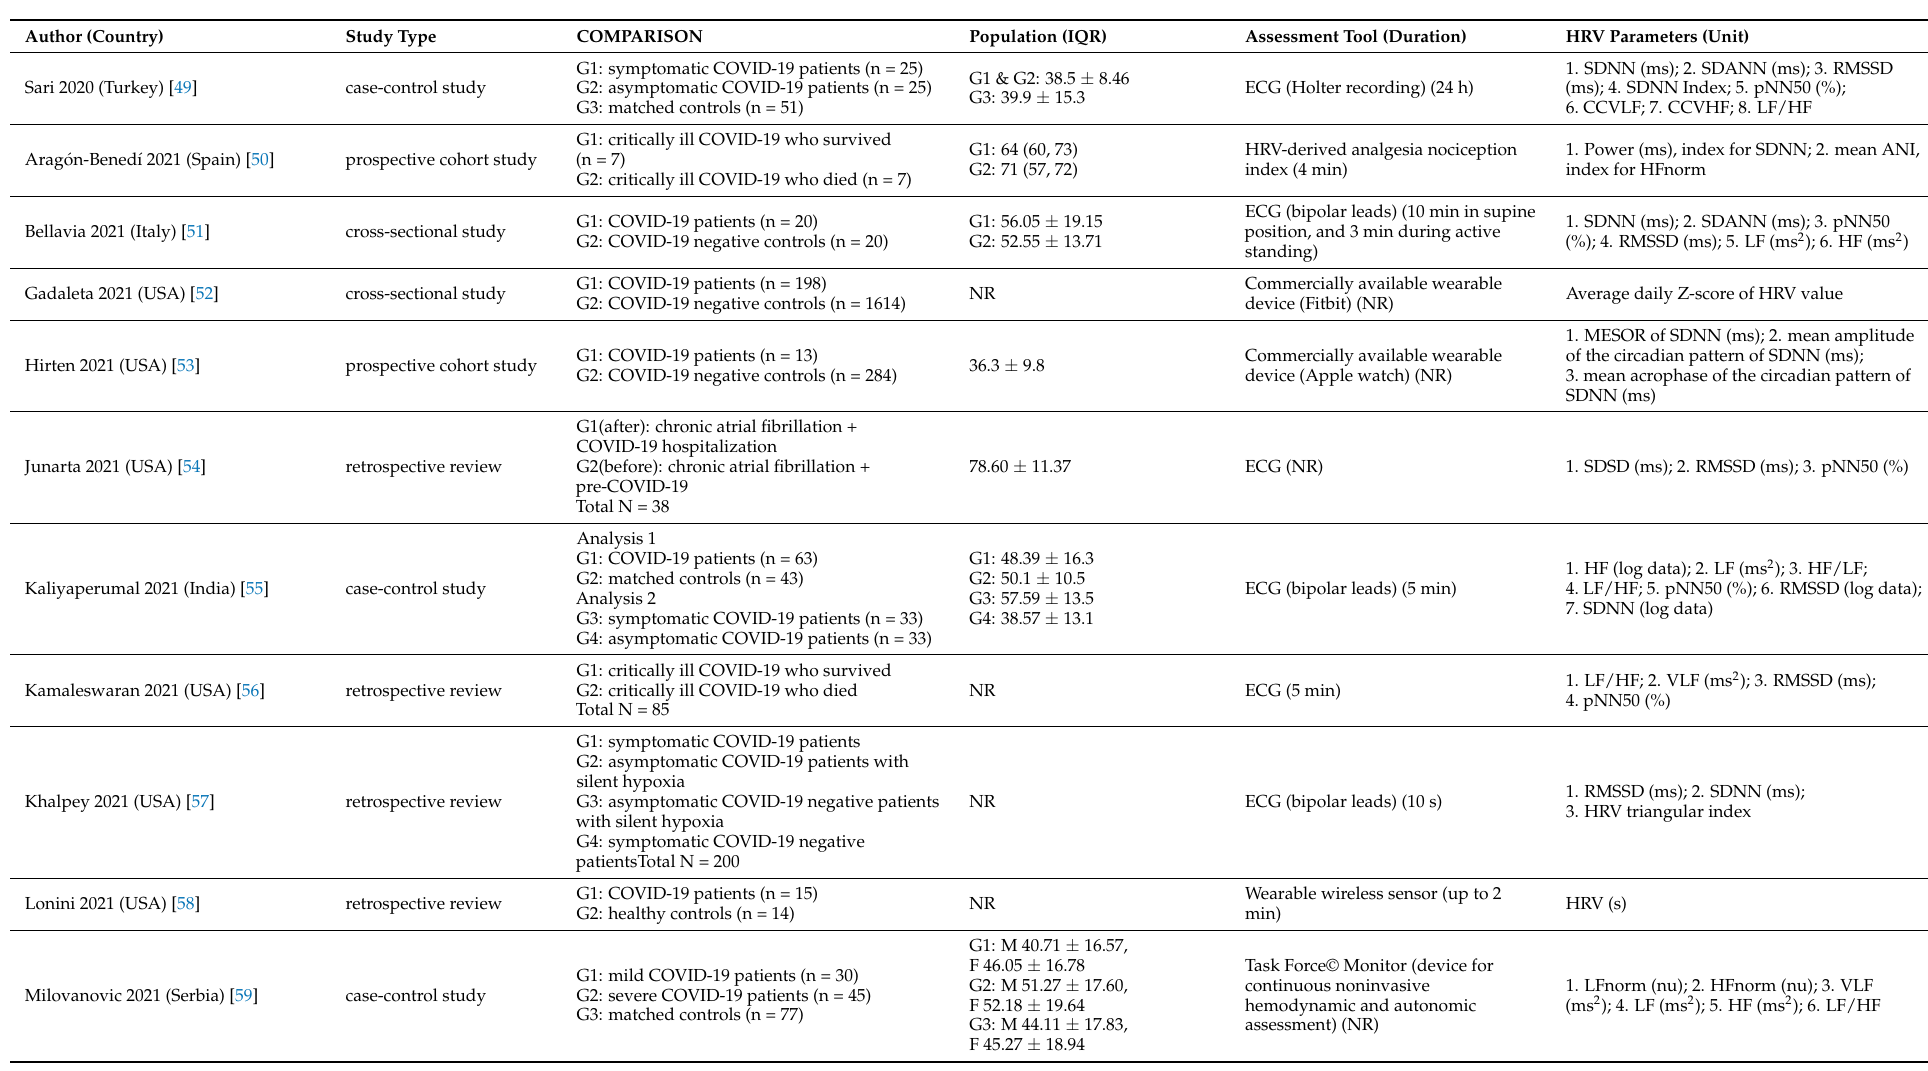
Table 1. Characteristics of included